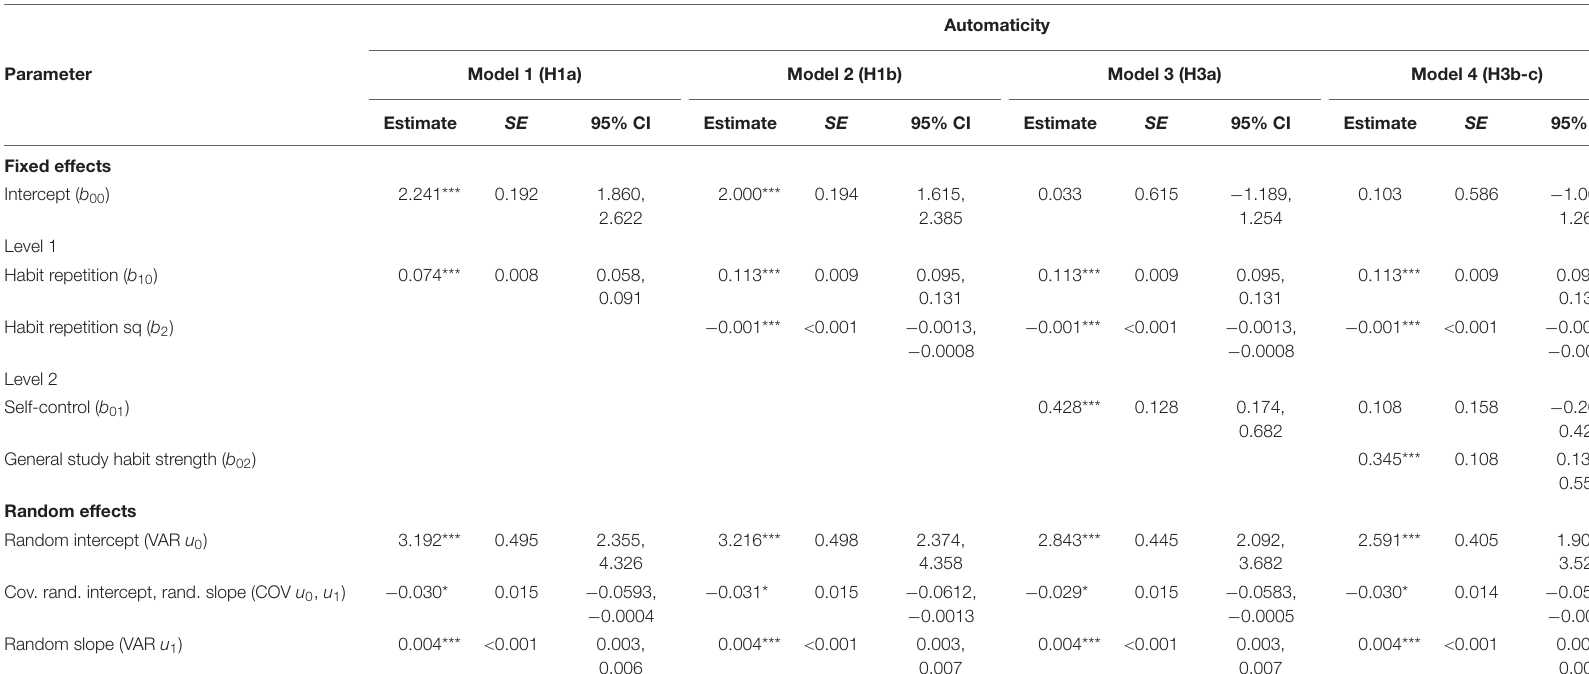
TABLE 1 | Multilevel regressions of automaticity on habit repetition, habit repetition squared, self-control and general study habit